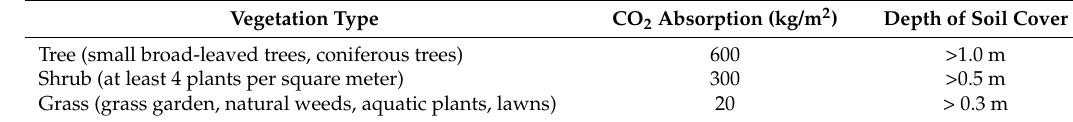
Table 1. The amount of carbon dioxide absorbed by various vegetation types in the 40-year life cycle [44]. Vegetation Type